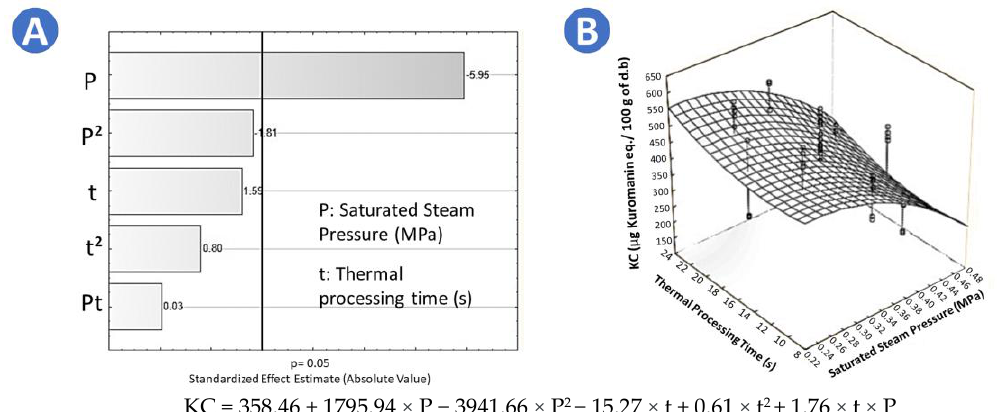
Figure 4. Effects of steam pressure (MPa) and thermal processing time (s) on the kuromanin concentration (KC) of swell-dried chokecherries. ( A ) Pareto chart and ( B ) surface response plot.